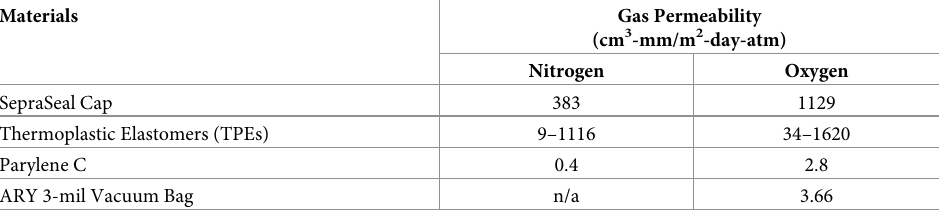
Table 1. Nitrogen and oxygen permeability data for SepraSeal cap and other relevant plastic materials; unavail- able data are labeled